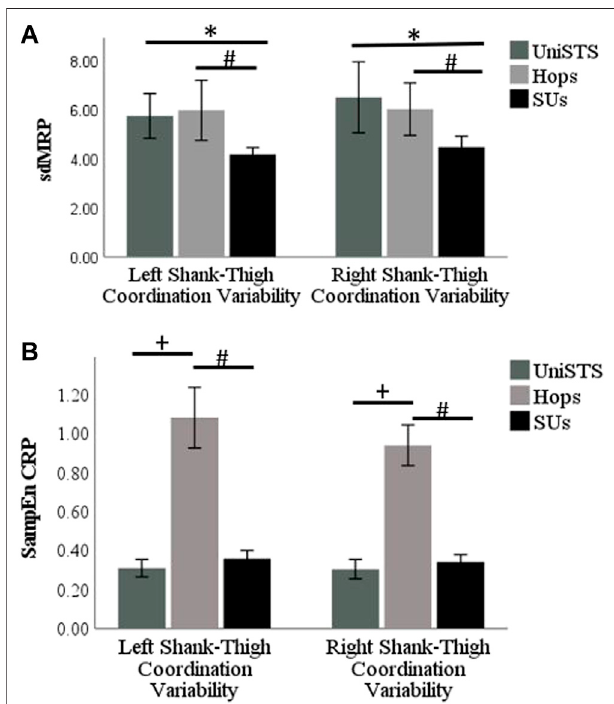
FIGURE 4 | (A) The bar plot of the linear right and left shank-thigh coordination variability results measured by the sdMRP of the participants in UniSTS,SUs,andHops. (B) Thebarplotofthenon-linearrightandleftshank- thigh coordination variability results measured by the SampEn CRP of the participants in UniSTS, SUs, and Hops. The signi fi cant differences ( p < 0.05, r > 0.5) are shown by * for UniSTS vs. SUs, # for Hops vs. SUs, and + for UniSTS vs. Hops.